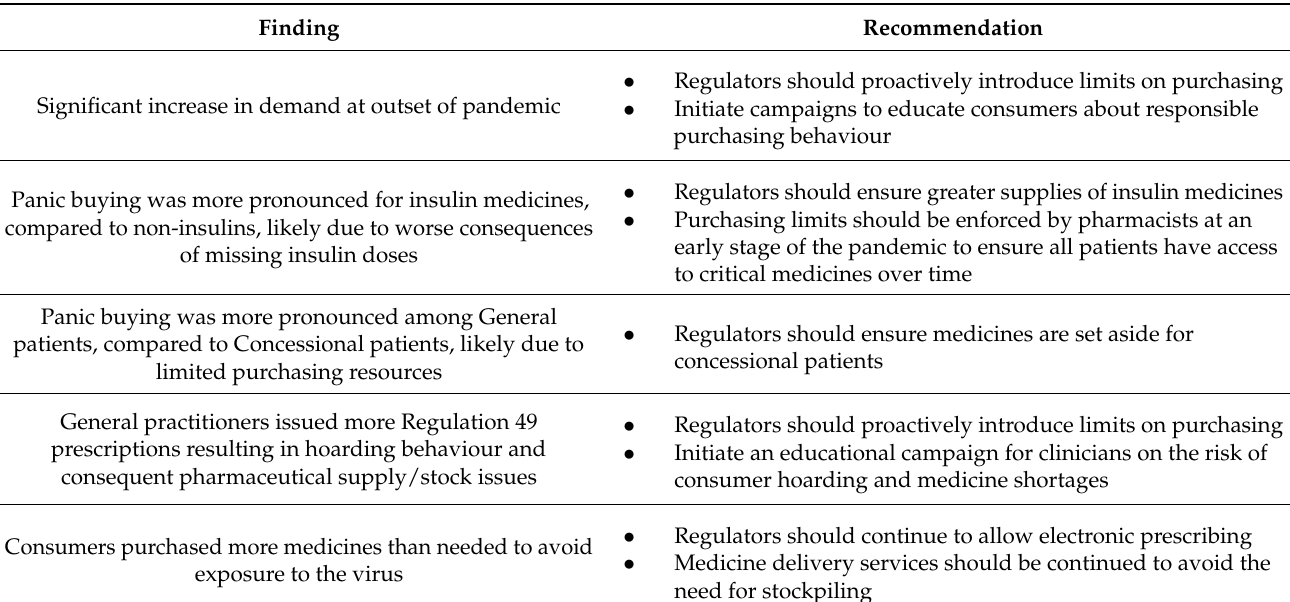
Table 2. Summary of study findings and